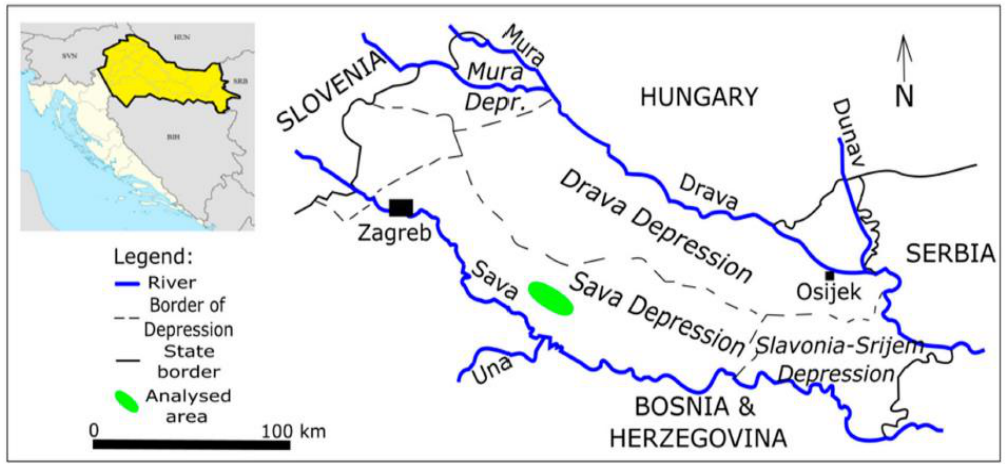
Figure 1. The location of field “B” in the Sava Depression (from [3]).